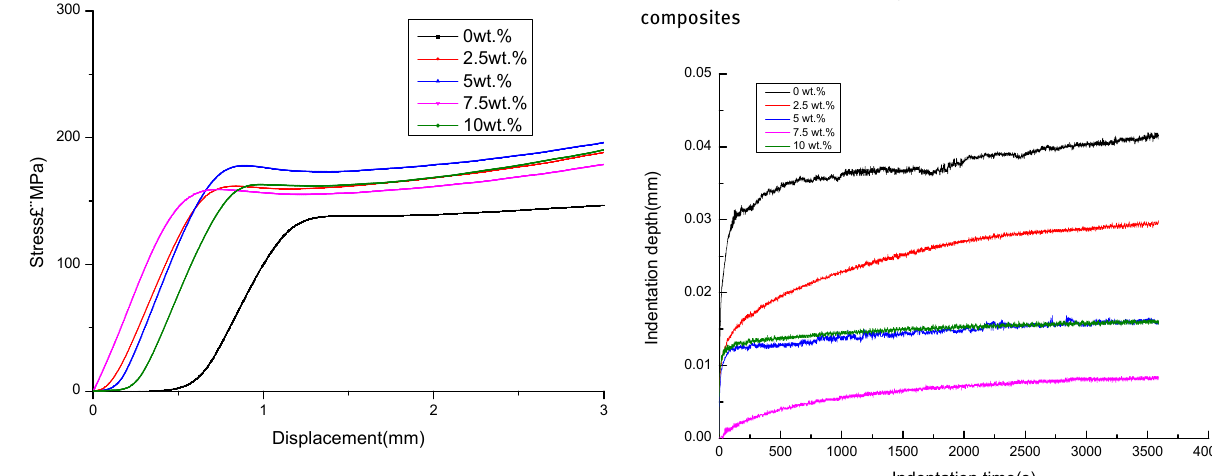
Figure 3: Stress-displacement curve of the PEEK/SBF composites